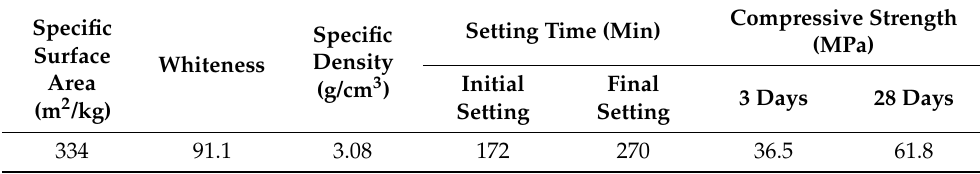
Table 1. Technical data of white Portland